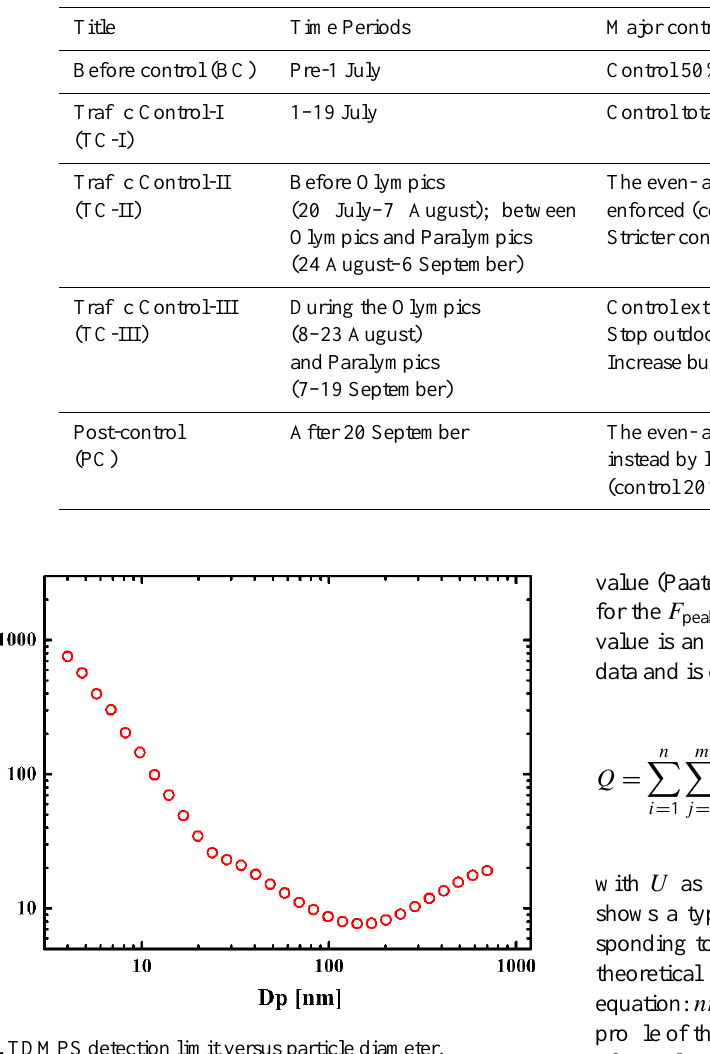
Table 1. Detailed information of different traffic control stages.